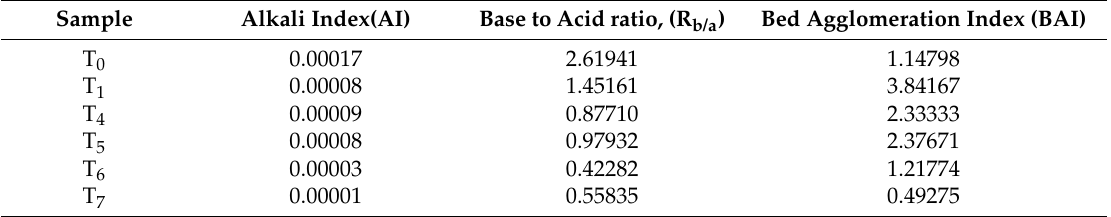
Table 6. Effect of HTC on the slagging, fouling and agglomeration